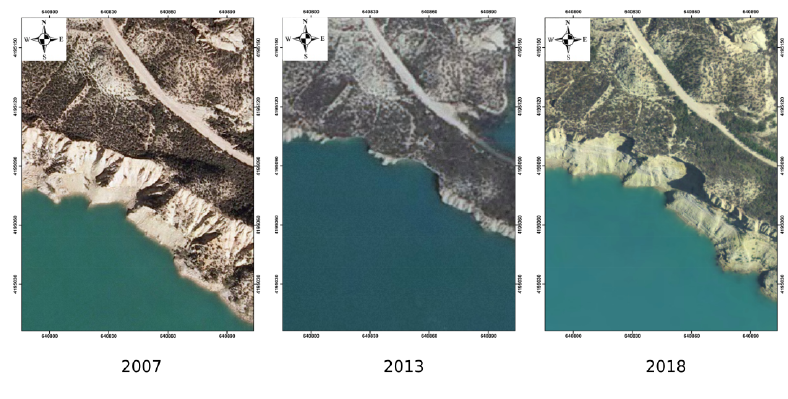
Figure 19. Bluff